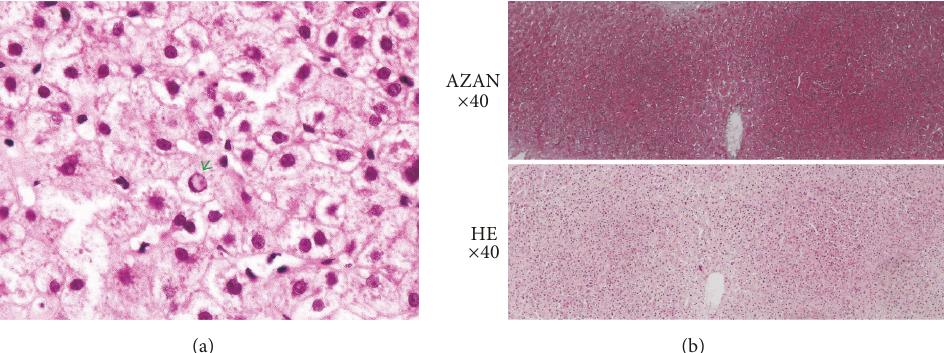
Figure 3: Findings of liver needle biopsy. (a) The arrow indicates a nuclear inclusion body. (b) Low magnification ( × 40) of a liver fragment with HE and AZAN staining.